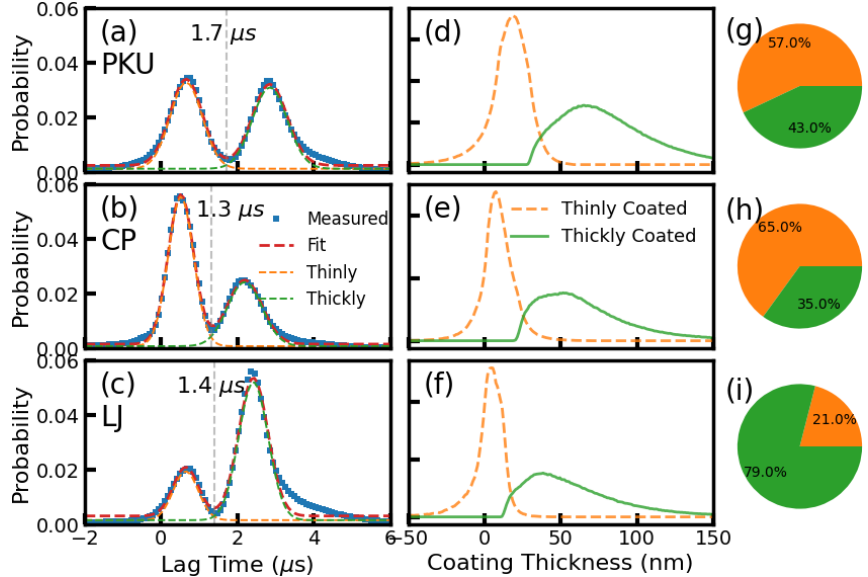
Figure 2. (a) The measured probability distribution of the lag time for the PKU site. Panel (d) shows the corresponding coating thickness distributions of thinly coated (orange) and thickly coated (green) BC-containing aerosols. Panel (g) gives the number fraction of the thinly coated (orange) and thickly coated (green) BC-containing aerosols. Panels (b) , (e) , and (h) are the corresponding values for the CP site. Panels (c) , (f) , and (g) give the results for LJ sites.